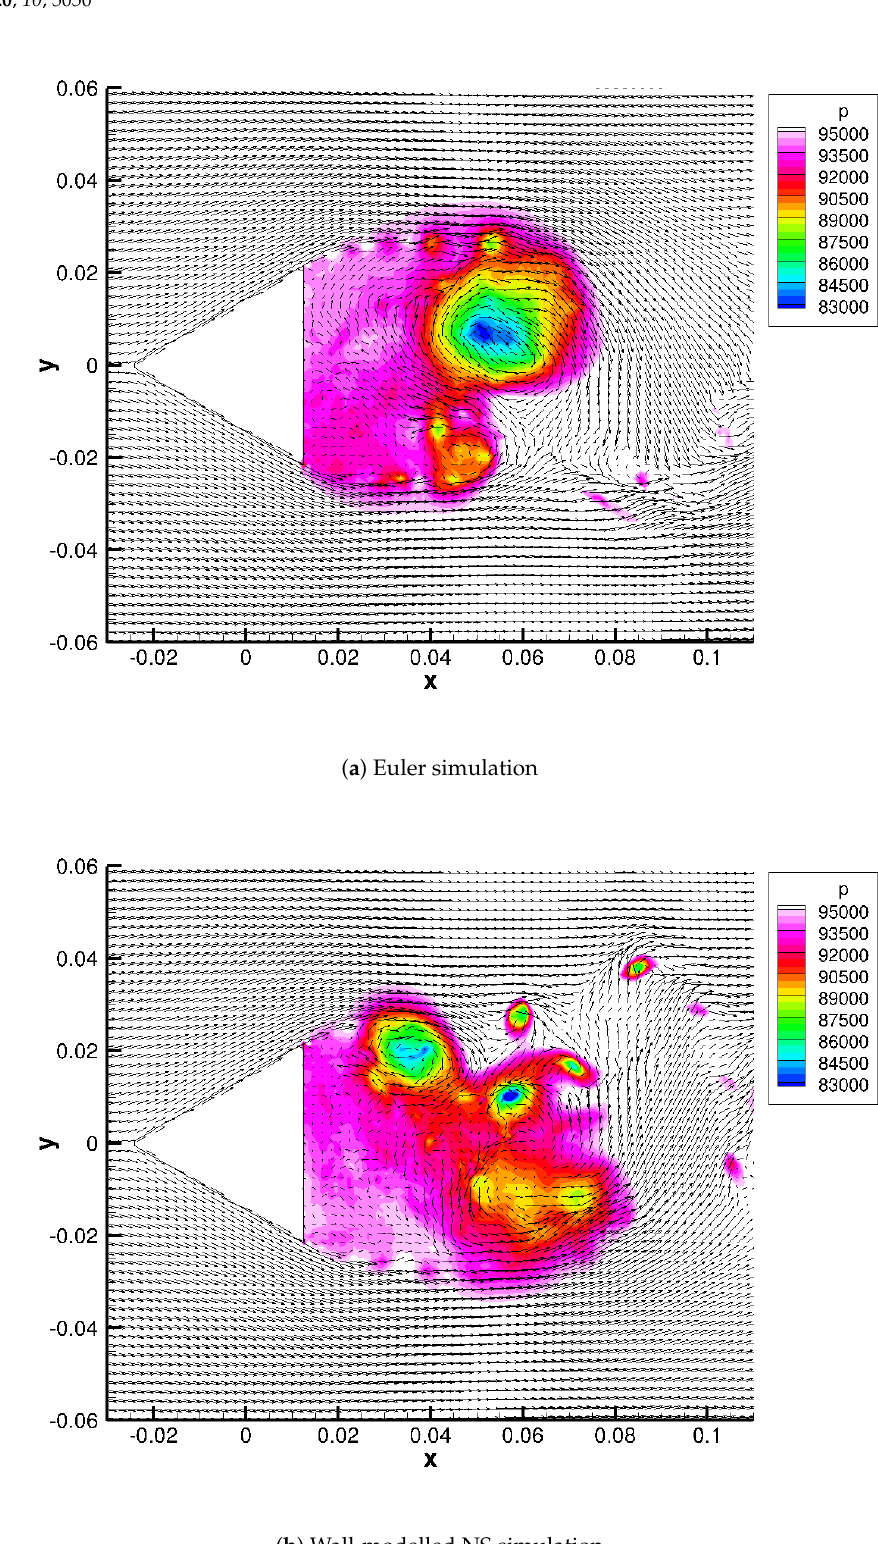
Figure 3. Pressure contour and velocity vectors at the z = const. plane of the fine grid simulation. Free shear layers form in the wake of the sharp edges, and the vortices form by the rollup of the free shear layers. Pressure in the wake of the wall-modelled Navier–Stokes simulation is similar to that of the Euler